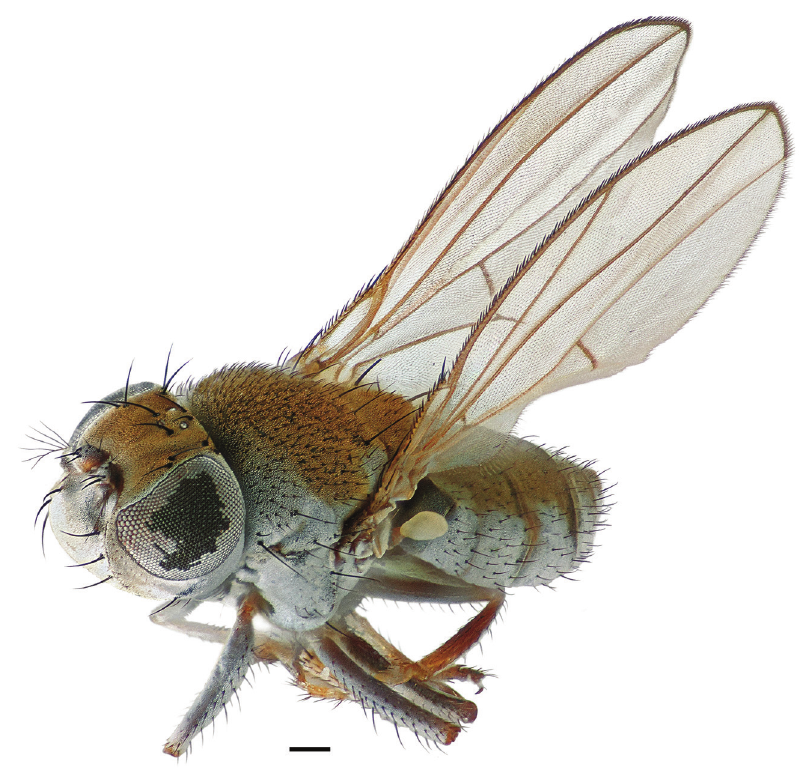
Figure 1. Habitus frontispiece of Hydrochasma williamsae sp. n. (Costa Rica. Cartago: La Suiza). Scale bar = 0.1